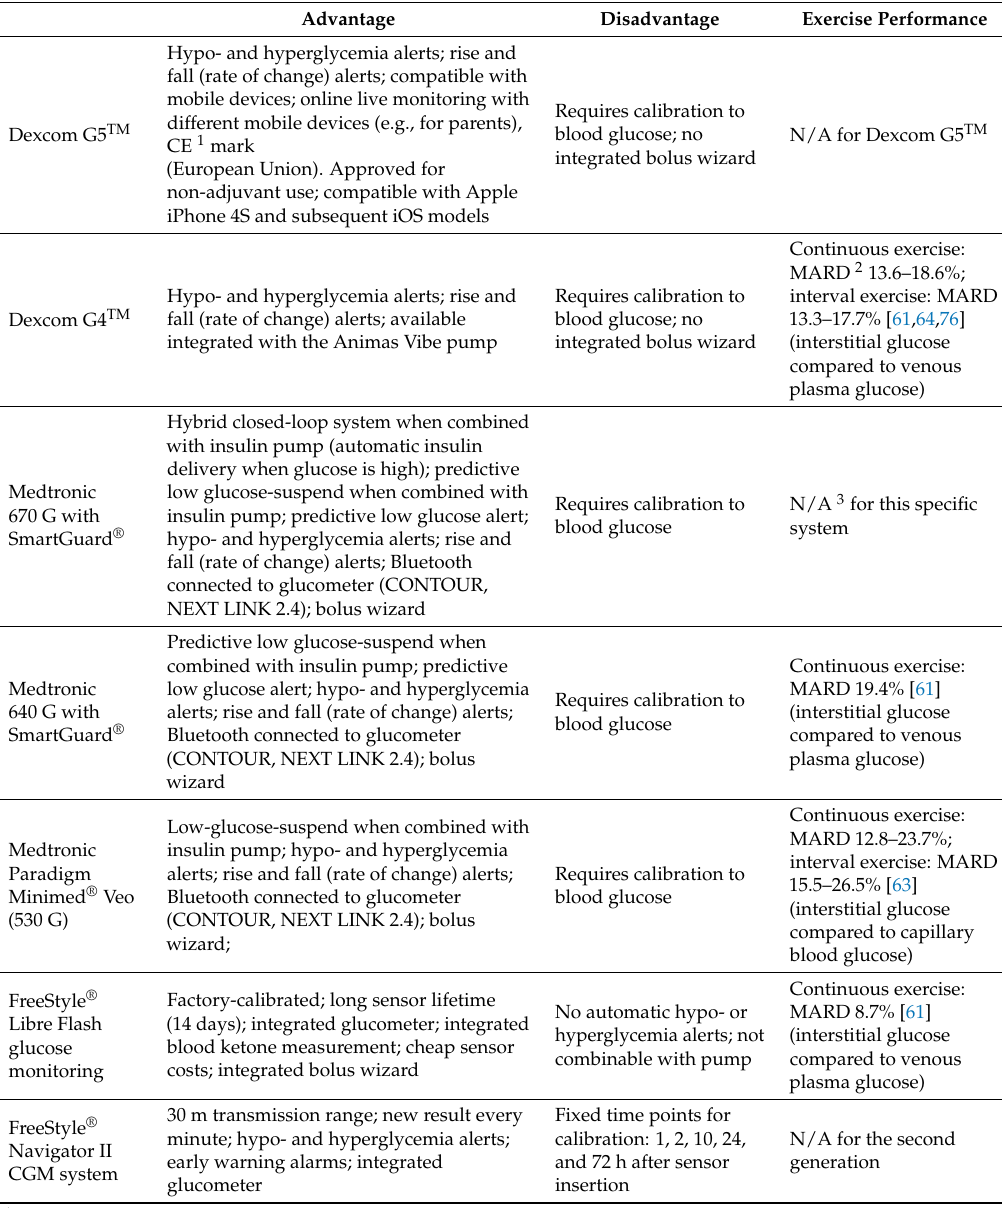
Table 2. Advantages, disadvantages, and exercise performance in continuous and flash glucose monitoring